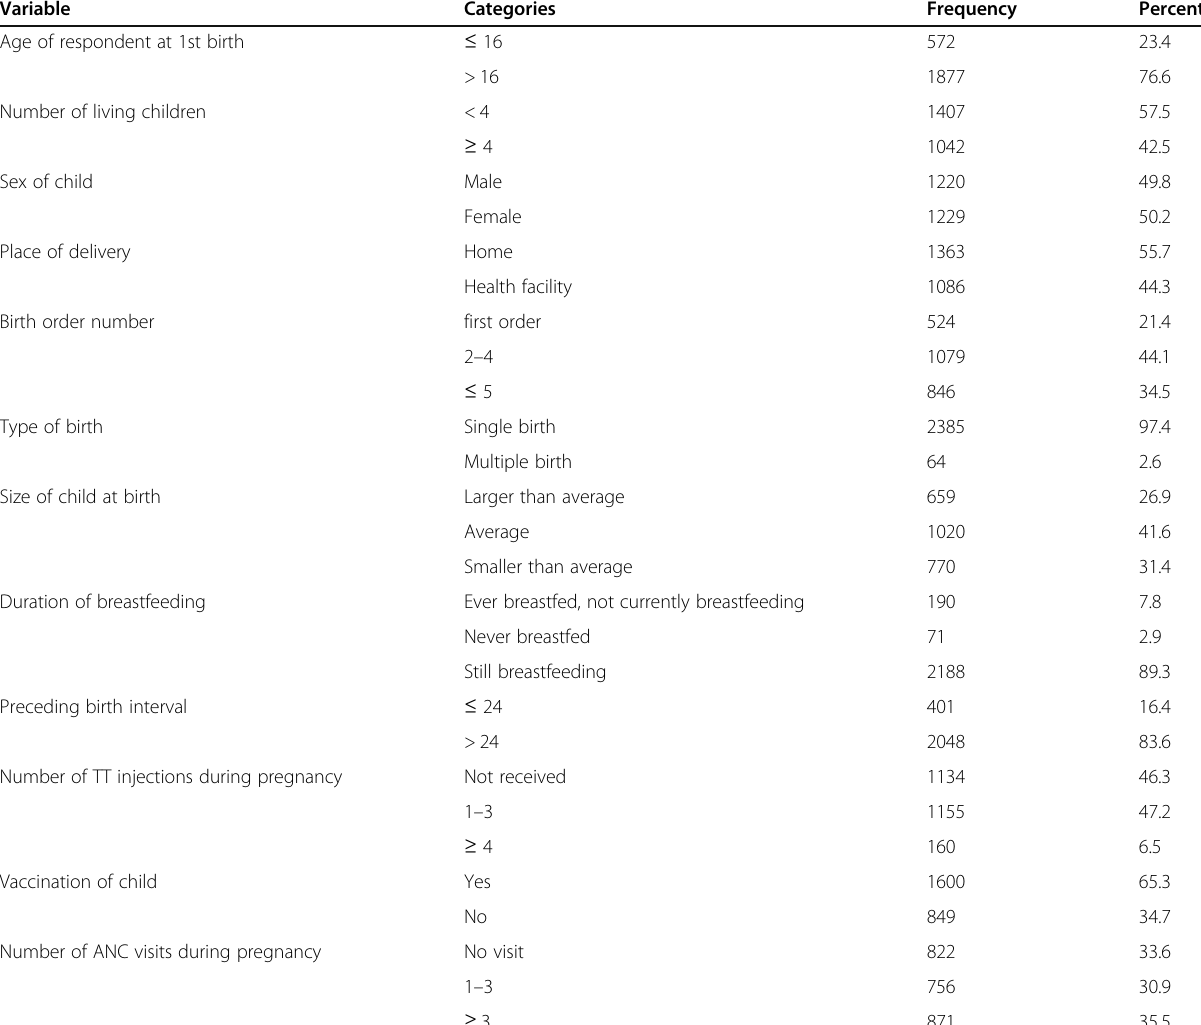
Table 2 Obstetric characteristics of respondents, EDHS